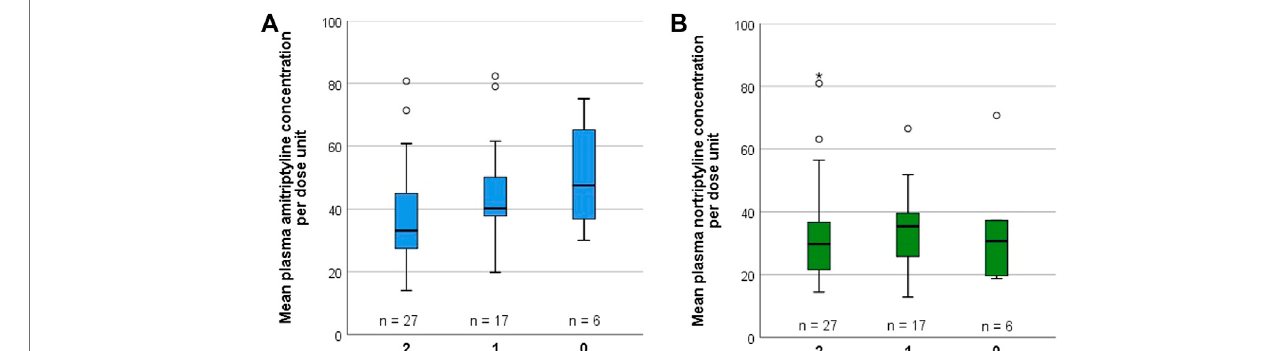
FIGURE 6 | Meanplasmaconcentrationsperdoseunitof (A) ATand (B) NT, strati fi ed byOCT1genotype,in50depressivedisorderpatientswhounderwentATtherapy.